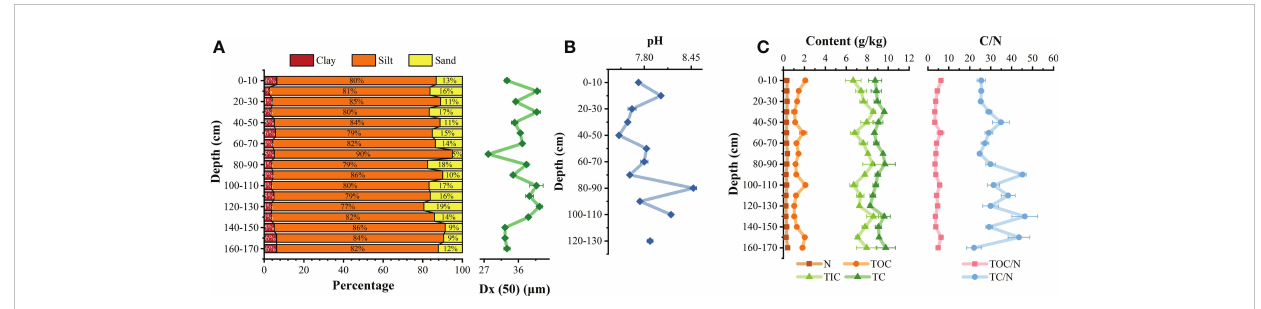
FIGURE 2 Vertical pro fi le distribution of particle size of sediment (A) ; vertical pH changes of pore water (B) ; Changes of total organic carbon (TOC) and carbon ratio to nitrogen (C/N) (C)